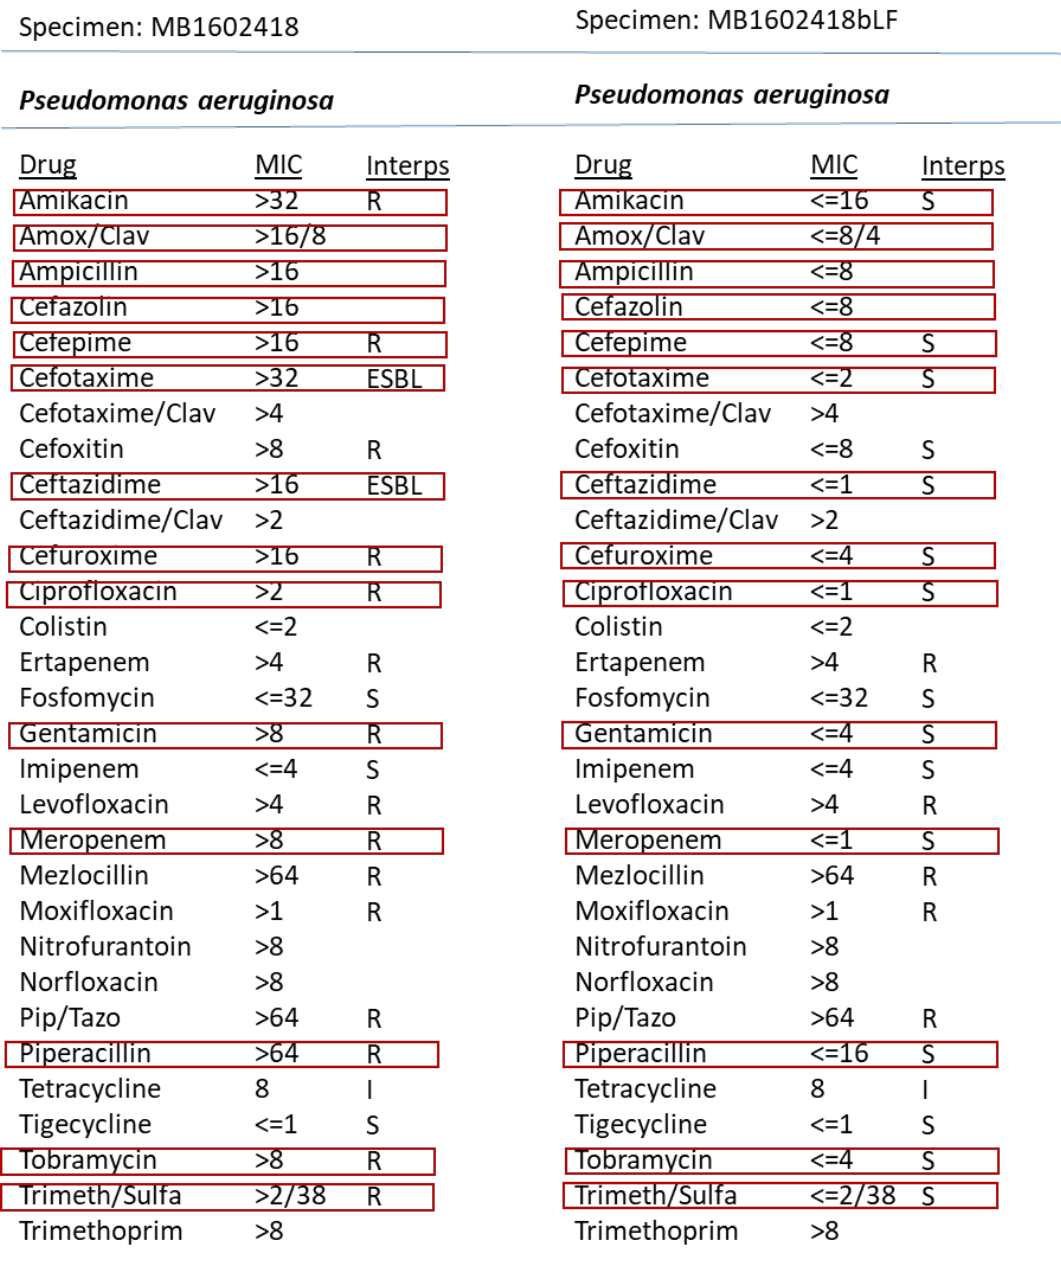
Figure 6. Demonstration of effect of bovine lactoferrin (bLF) on Carbapenemase producing (cephalosporin and carbapenem resistant) clinical Pseudomonas